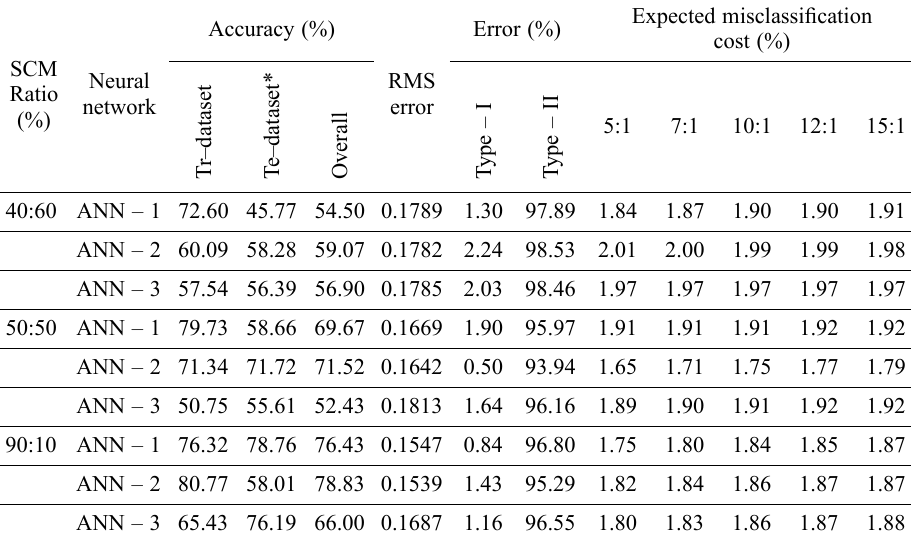
Table 6. Performance obtained by the Chinese